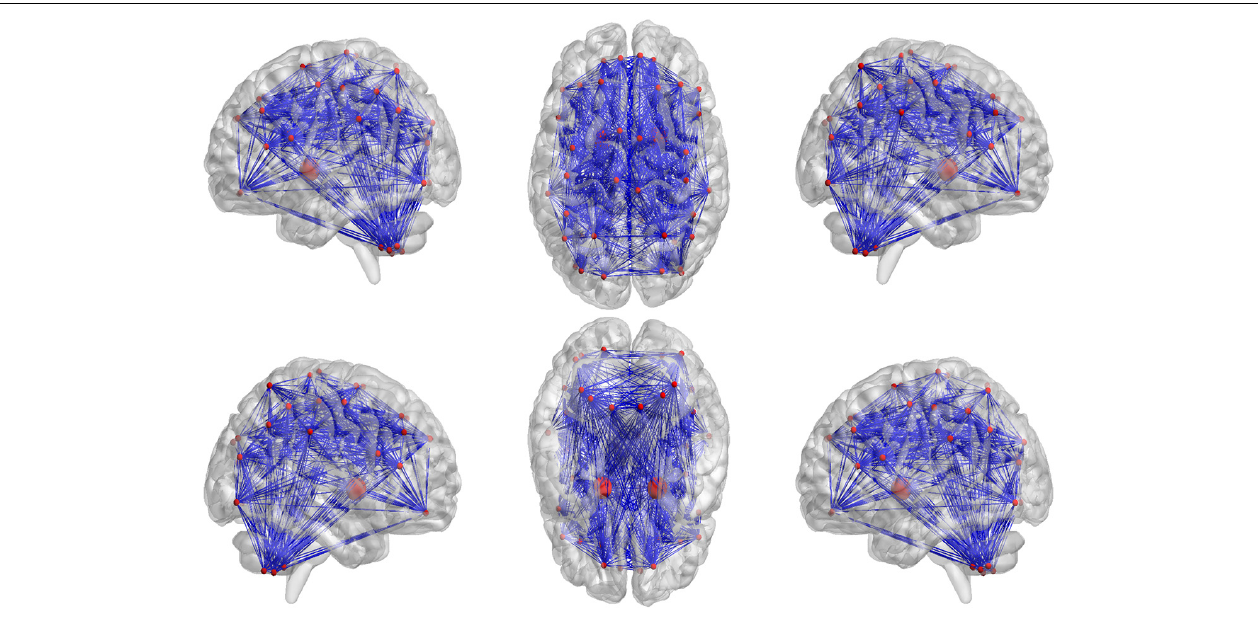
FIGURE 6 | The top 42 regions which have the largest contributions to correctly classifying ASD patients were identified. As seen in our result, the pallidum in the left and right hemispheres have been found to be more significant and specific for ASD, which are drawn larger than other